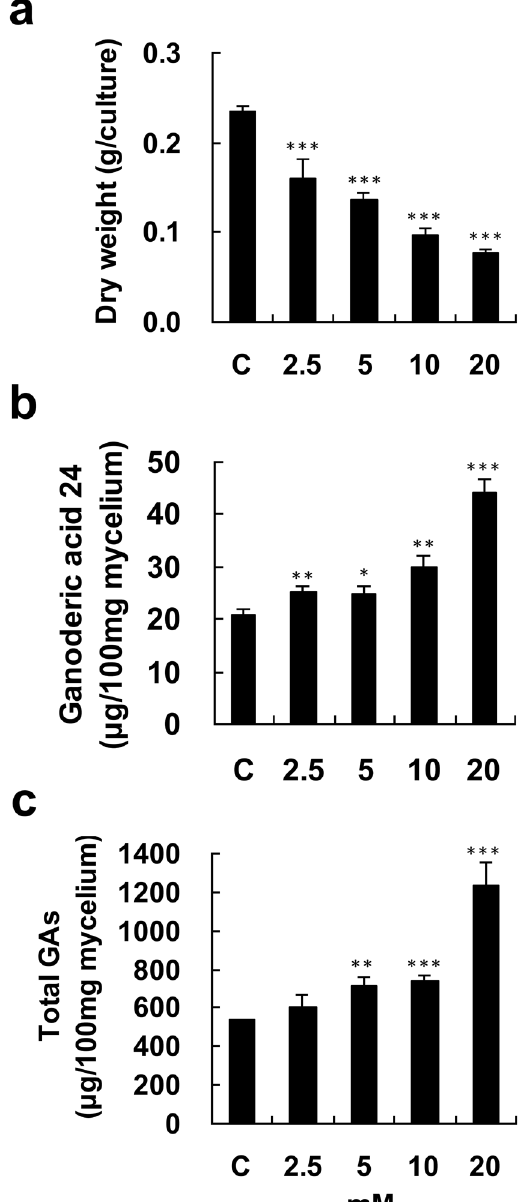
Figure 4. Effect of NaF on fungal biomass and production of ganoderic acids by Ganoderma lucidum . Four- day-old fungal mycelium was cultured on potato dextrose agar (PDA) in 9-cm diameter petri dishes and then incubated with 2.5–20 mM NaF in 25 ml potato dextrose broth (PDB) for 4 days. Dried mycelium was used to measure fungal biomass ( a ). Both lanosta-7,9(11), 24-trien-3 α -o1-26-oic acid (ganoderic acid 24) ( b ), and total ganoderic acids (GAs) ( c ) were measured by HPLC. The means of three independent samples with standard deviations are presented. * p < 0.05, ** p < 0.01, *** p < 0.001 as compared with the control